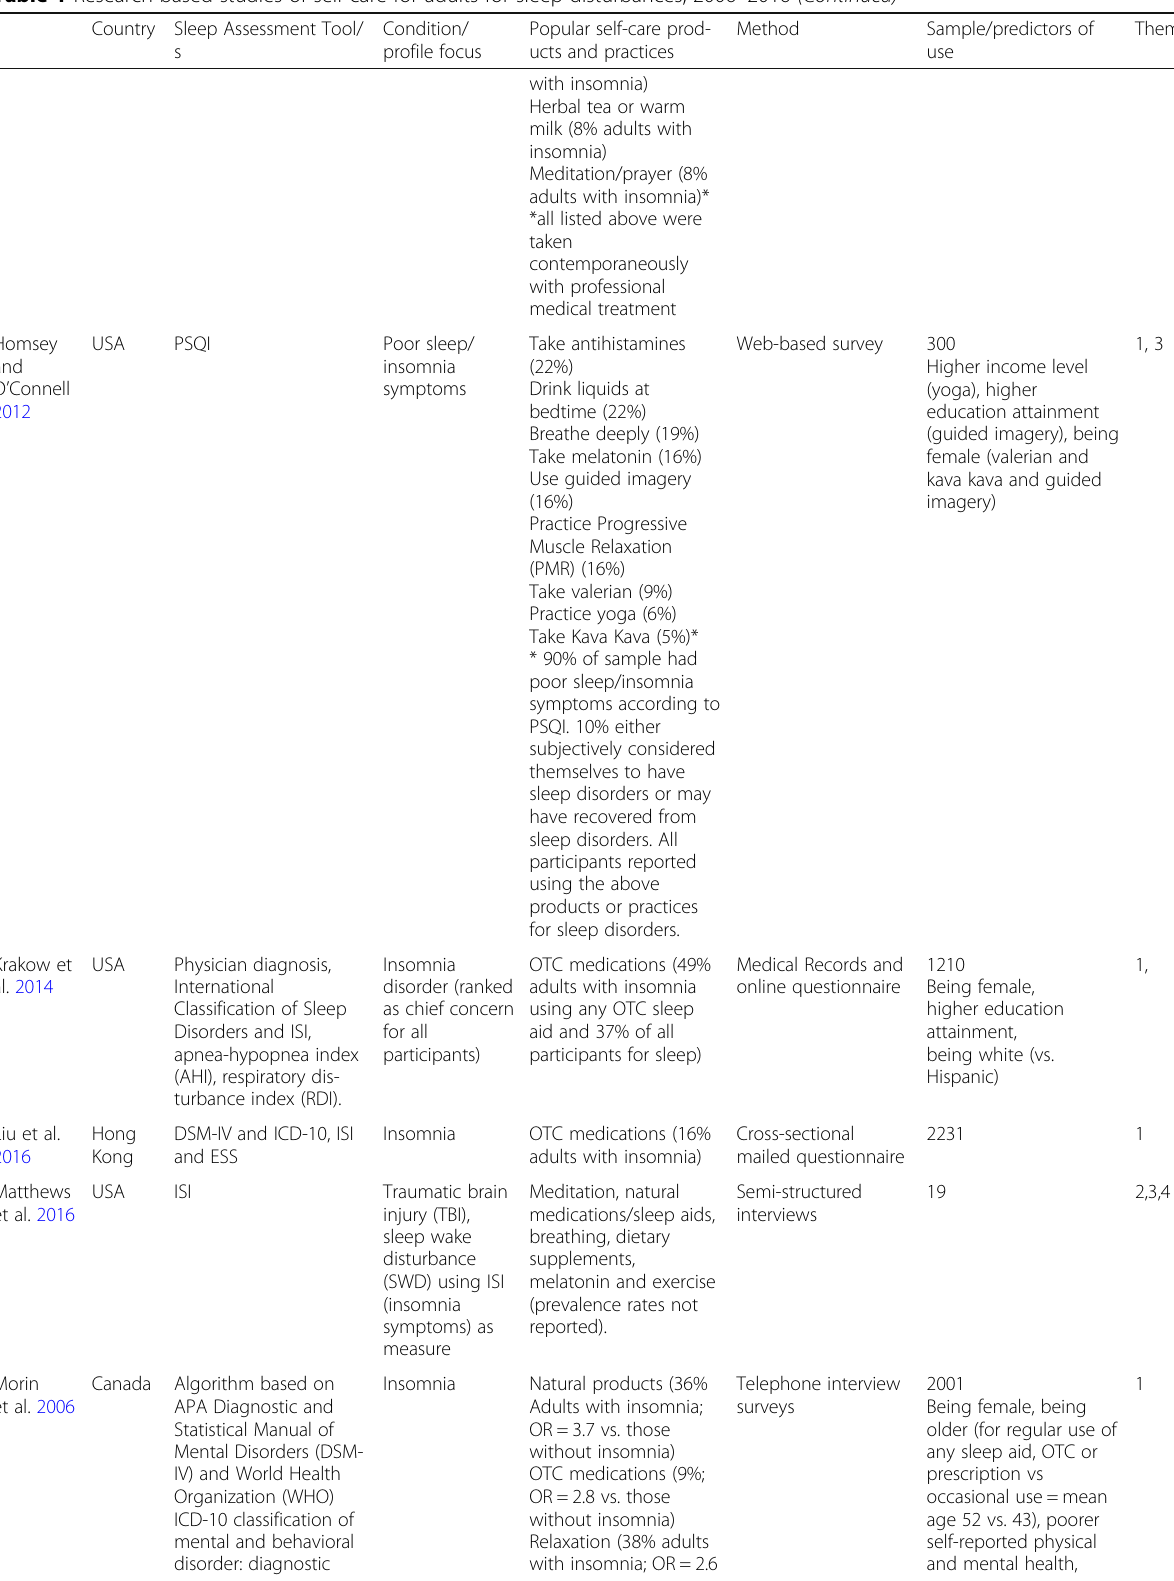
Table 1 Research-based studies of self-care for adults for sleep disturbances, 2006 – 2016 (Continued) Country Sleep Assessment Tool/